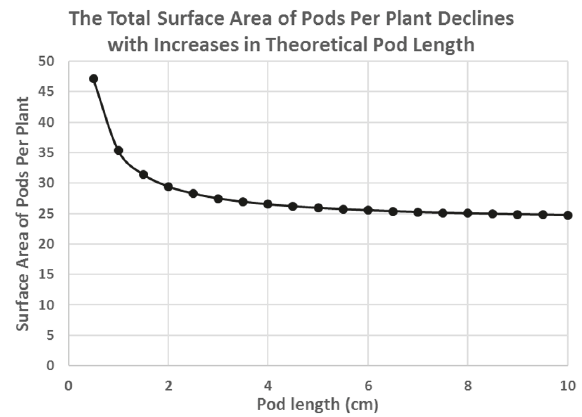
Figure 1: Pod length and pod surface area (assuming a seed yield per plant of 15 seeds and a 0.5 cm seed diameter).